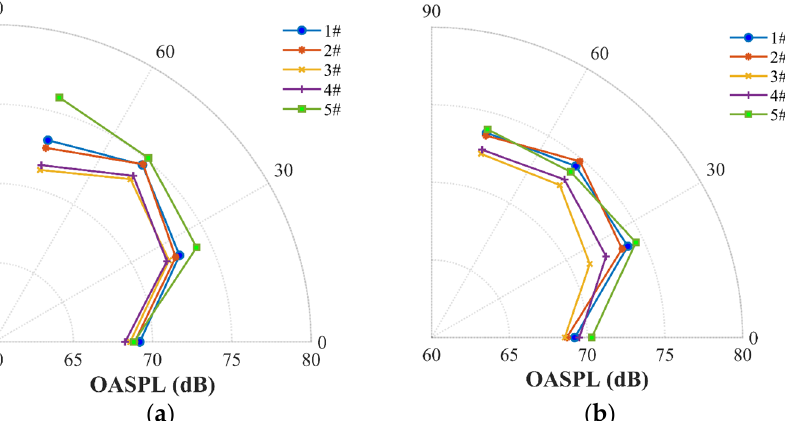
Figure 8. Comparison of OASPL among the two-blade propeller (#1), four-blade propeller (#2), loop-type propeller (#3), wide chord loop-type propeller (#4), and DJI Phantom III propeller (#5) at a rotational speed of 5400 rpm ( a ) and at a stable thrust of 3 N ( b ).